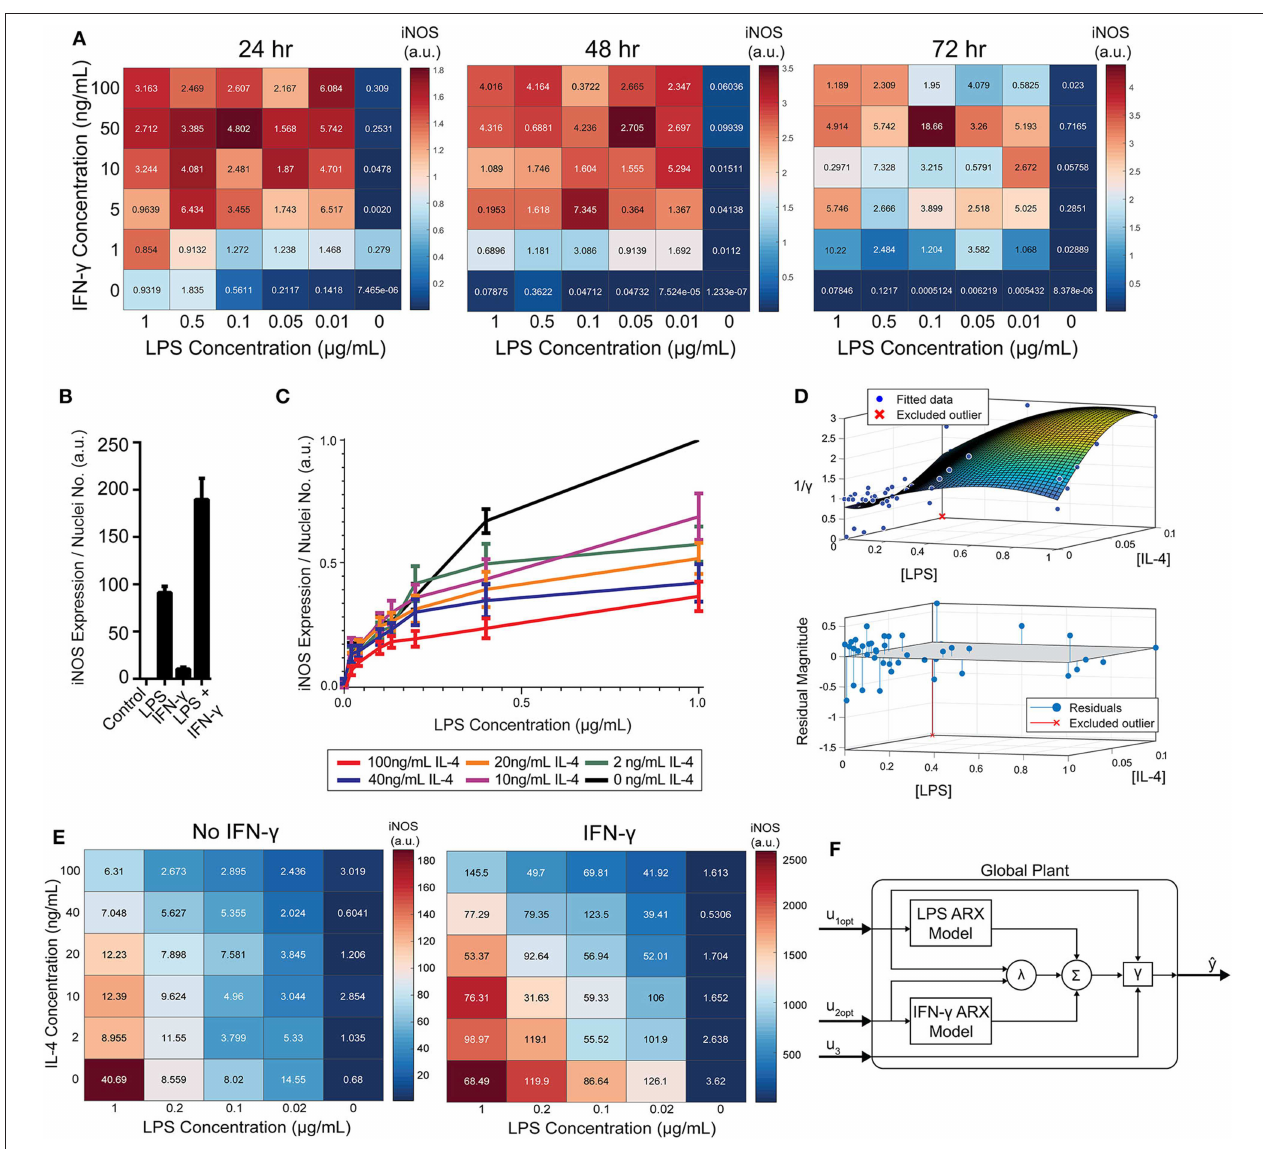
FIGURE 5 | RAW 264.7 macrophages are markedly affected by activation state-dependent hysteresis, which can be overcome using multiple pro-inflammatory inputs. (A) LPS and IFN- γ added simultaneously cause time dependent supra-additive expression of iNOS (color represents mean, SEM displayed numerically, N = 2). Data are normalized by 1 µ g/mL LPS-only condition for each time-point. (B) Selected non-normalized data from A (24h, highest concentration per stimulus) demonstrating that iNOS expression from combined conditions is greater than the linear addition of LPS or IFN- γ alone (mean ± SEM, N = 2). (C) Prior treatment with IL-4 attenuates LPS induced iNOS expression (24h post-LPS treatment) in an IL-4 concentration-dependent manner (mean ± SEM, N = 6). (D) Interpolated attenuation factor gamma surface plot (top) and fit error (bottom). (E) Pretreating macrophages with 100ng/mL IL-4 for 24h prior to LPS stimulation reduced the magnitude of pro-inflammatory polarization measured by iNOS expression normalized to DAPI (color represents mean, SEM displayed numerically, N = 4). Combining 4ng/mL of IFN- γ with LPS stimulates iNOS expression, overcoming the hysteretic effect dependent on the dose of LPS (color represents mean, SEM displayed numerically, N = 4). (F) Diagram of global plant, as implemented in control system ( Figure 1B ), of multiple input system with both linear and non-linear model elements. System predicted inputs u 1 (LPS) and u 2 (IFN- γ ) are fed into respective identified SISO ARX models and supra-additive interaction term λ elements. Terms multiplied by weighting coefficients c (defined by multiple regression estimation; Equation 10) prior to summation ( 6 ) and hysteresis-dependent attenuation ( γ ). Note that u 3 accounts for IL-4 attenuation via γ